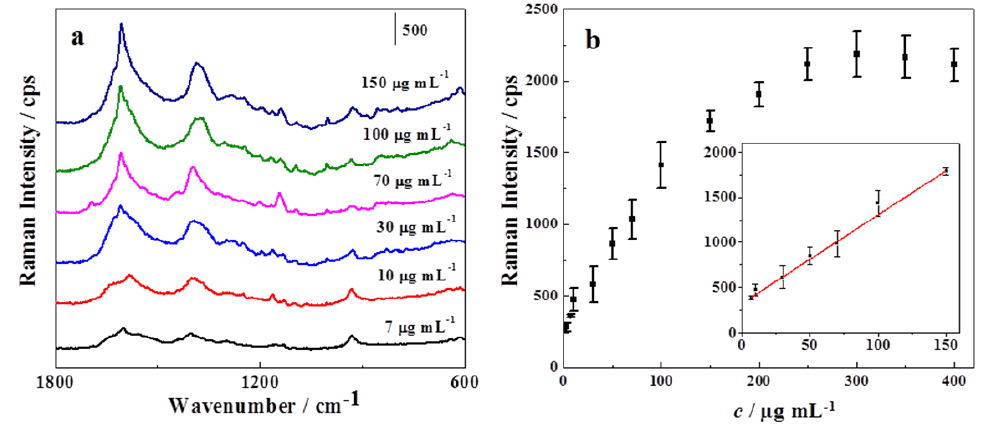
Figure 6. ( a ) SERS spectra of different concentrations of SH; ( b ) A correlation between the Raman intensity at 1594 cm −1 and the concentration of SH. The inset in ( b ) showed the linear range within 7–150 µg · mL −1 between the intensity at 1594 cm −1 and the concentration of SH. By choosing the peak intensity at 1594 cm −1 as a reference, the correlation between the Raman intensity and SH concentration was obtained as shown in Figure 6b, which had a good linearity over the concentration range of 7–150 µg·mL −1 with a regression coefficient R 2 of 0.986 and a detection limit (LOD) as low as 3 µg·mL −1 . Such a facile and sensitive method was much better than previously